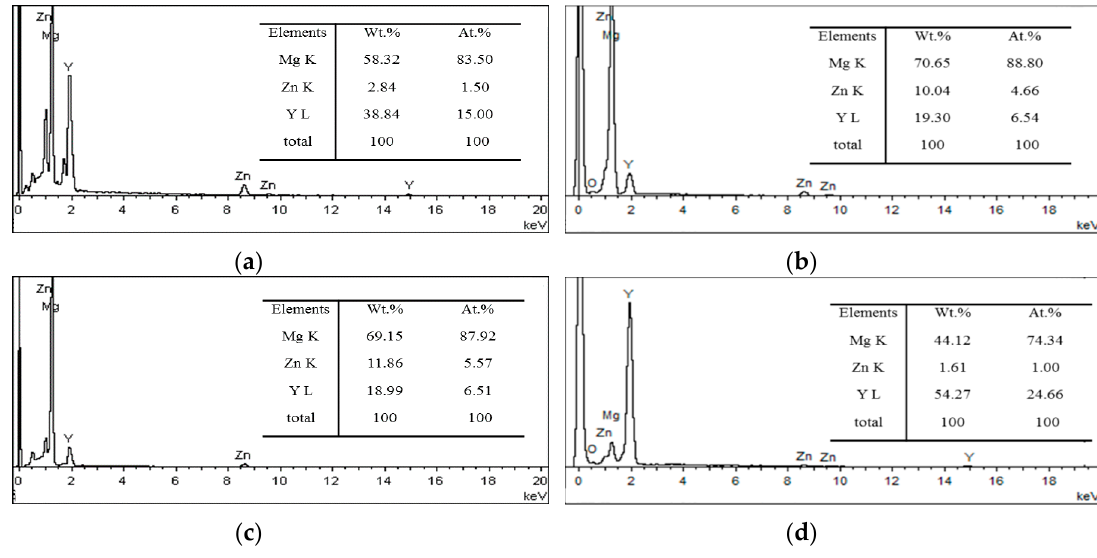
Figure 3. Energy dispersive X-ray spectrometer (EDS) results ( a ) Point A, ( b ) Point B, ( c ) Point C and ( d ) Point D for the main phases in as-cast and pre-extrusion heat-treated alloys.